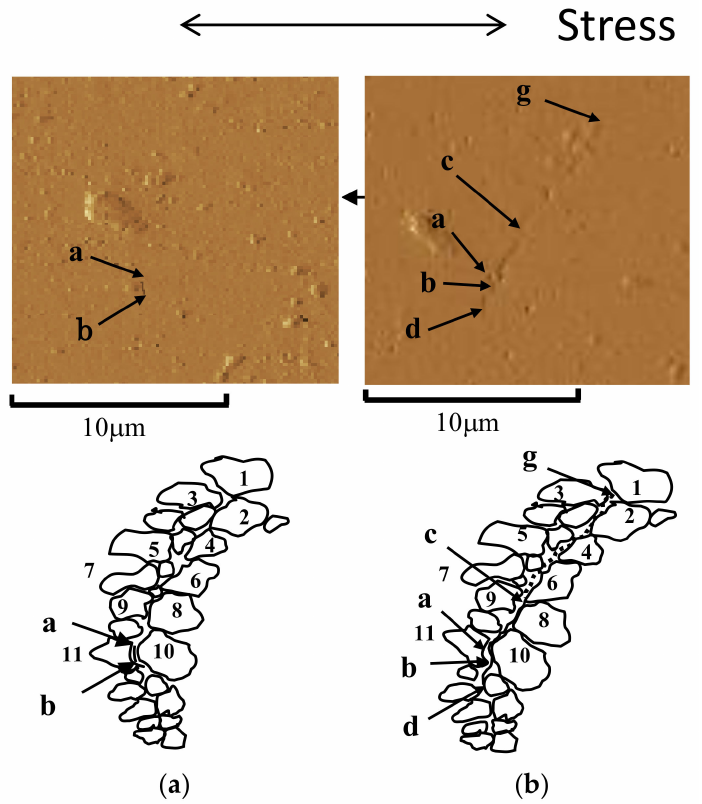
Figure 5. Interaction between cracks and microstructure (specimen P, σ a = 200 MPa, N f = 5.7 × 10 6 ). ( a ) N/N f = 10%; ( b ) N/N f =